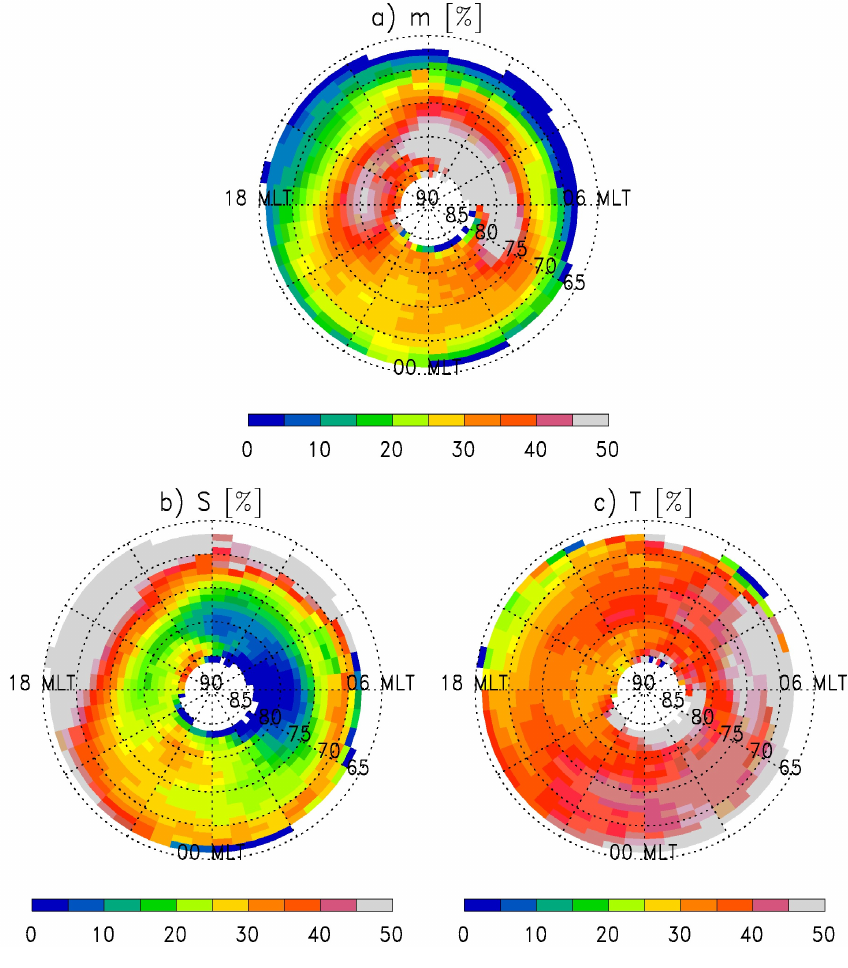
Fig. 4. Occurence an ACF of (a) class m, (b) class S and (c) class (T).